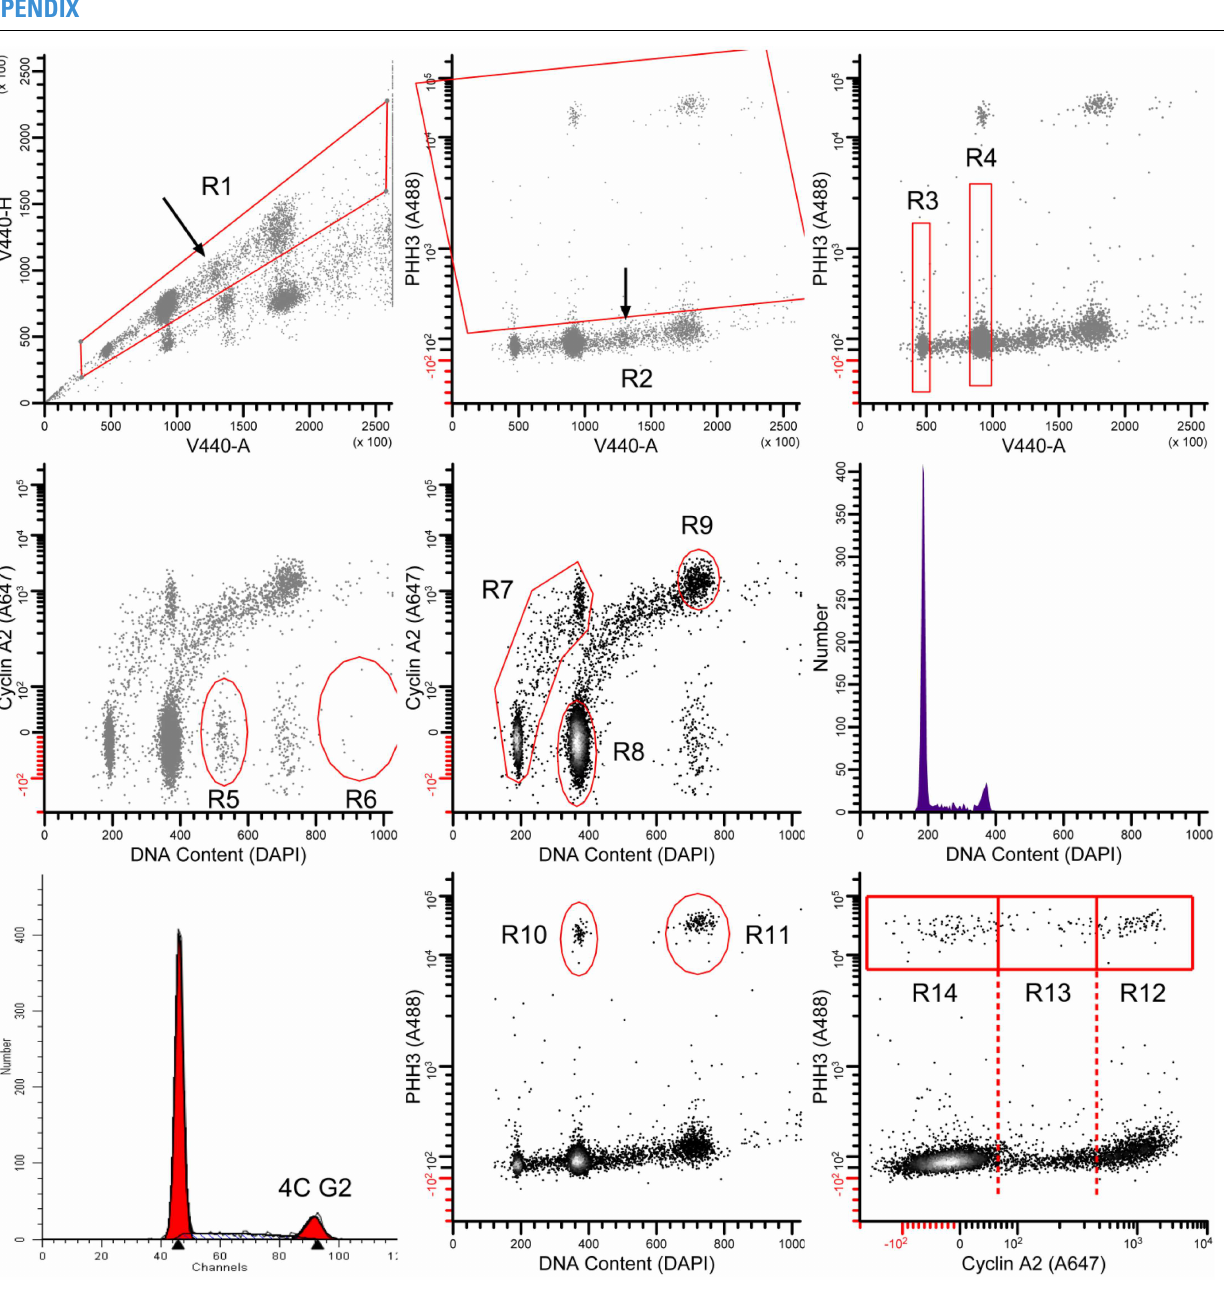
cluster. R7 was used to isolate the interphase stem line (2C → 4C). R8 and R9 were used to quantify 4C G1 and 8C G2 cells, respectively.The middle, right panel shows the DNA content histogram for the stem line, gated on (R1 AND R7 AND NOT R2).This histogram was analyzed by ModFit LT 3.2 (Verity Software House) to quantify 4C G2 cells (bottom, left panel). R10 and R11 were used to quantify the bulk of mitotic cells. These gates exclude early prophase and late telophase/cytokinetic cells. Finally, R12, R13, and R14 were used to quantify cells in the P4, PM, and M-LM mitotic states. For further description of mitotic states, see Ref. (16,